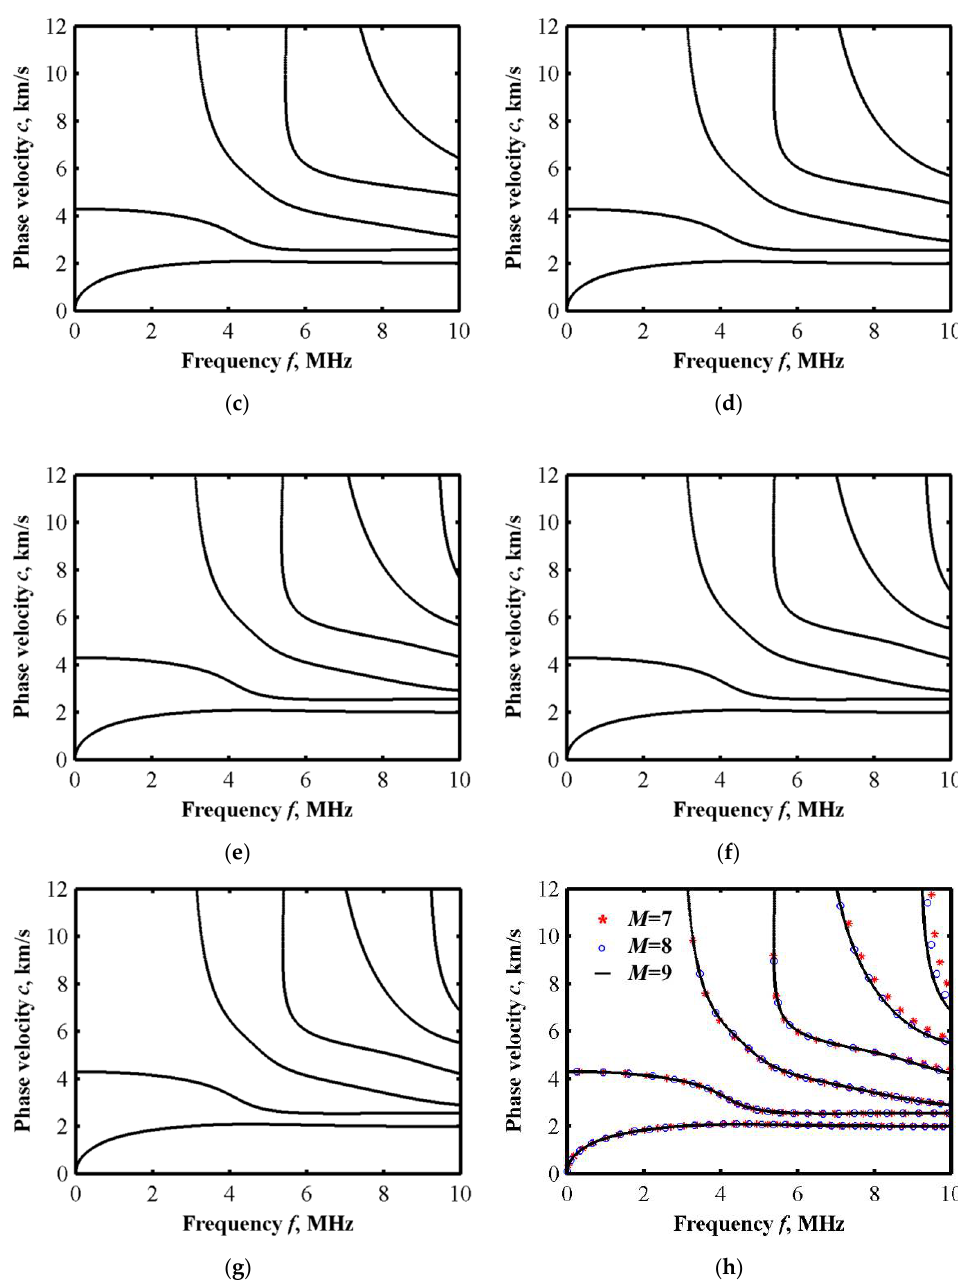
Figure 3. Lamb wave dispersion curves under different cutoff orders: ( a ) M = 3; ( b ) M = 4; ( c ) M = 5; ( d ) M = 6; ( e ) M = 7; ( f ) M = 8; ( g ) M = 9; ( h ) M = 7, 8, 9 comparison. Taking the volume fraction curve at n = 0.2 as an example, according to Equation (10), the elastic constant C IJ and density ρ of the FGM layer can be sliced into 10 equal minor sub layers. Meanwhile, when N = 1, the corresponding material layer is Cu; and when N = 10, the corresponding material layer is steel, and the material parameters can be obtained from Table 1. The thickness of each layer is 0.02 mm, and the material parameters vary in the same step. The corresponding parameters of all layers can be obtained from Equation (10), which are shown in Table 2. Table 2. Parameters of sliced FGM layer.